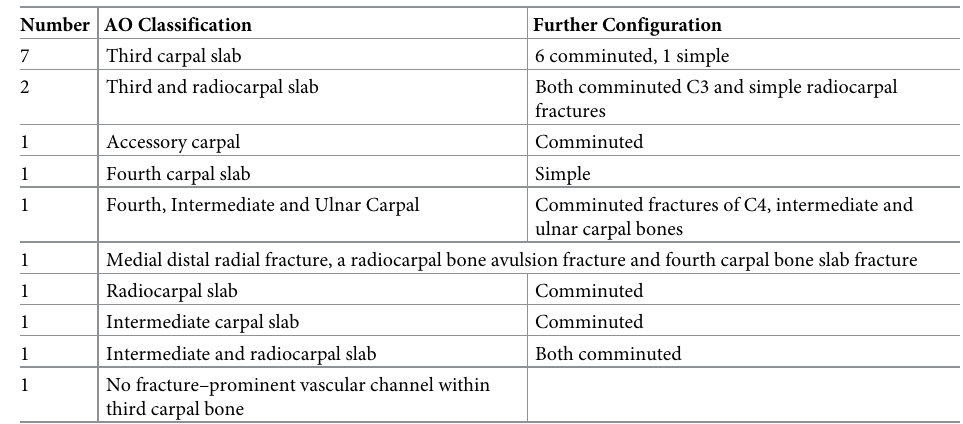
Table 2. Carpal bone